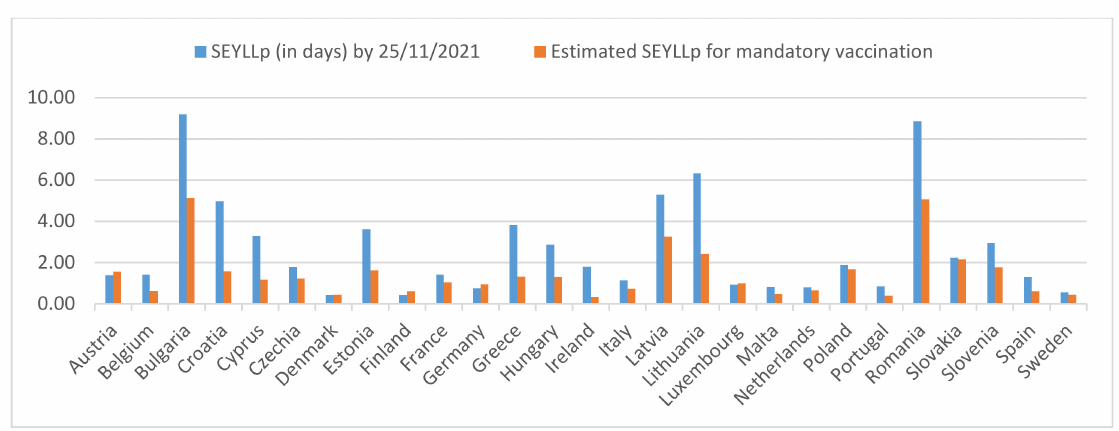
Figure 4. Differences between the 27 EU countries’ SEYLL p for the 60+ population by 25 November 2021, and their estimated respective values in the case of a mandatory vaccination using SHARE COVID-19 upper vaccination